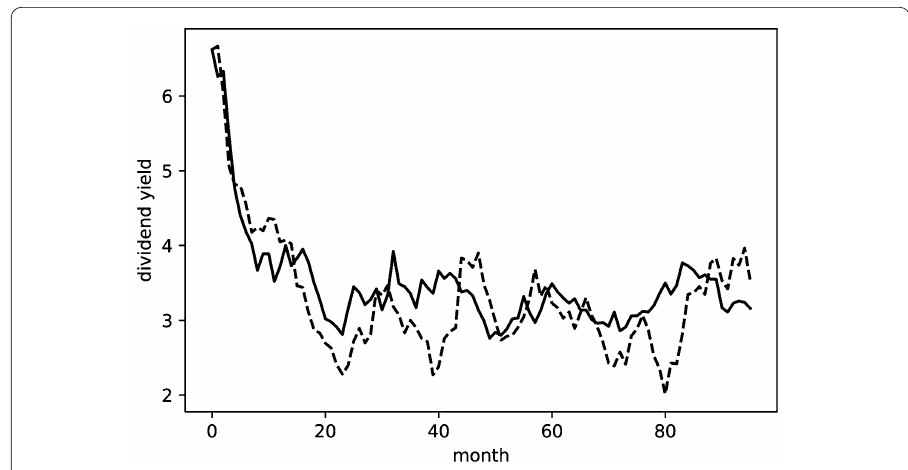
Figure 4 Sample of MSEY model simulated path (dashed line) compared to actual data (normal line)